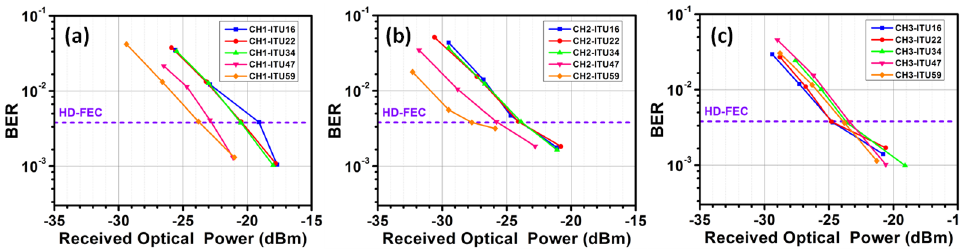
Figure 8. Measured BER curves of some selected wavelength channels of the 3 × 3 modes switch (a) CH1, (b) CH2 and (c) CH3.